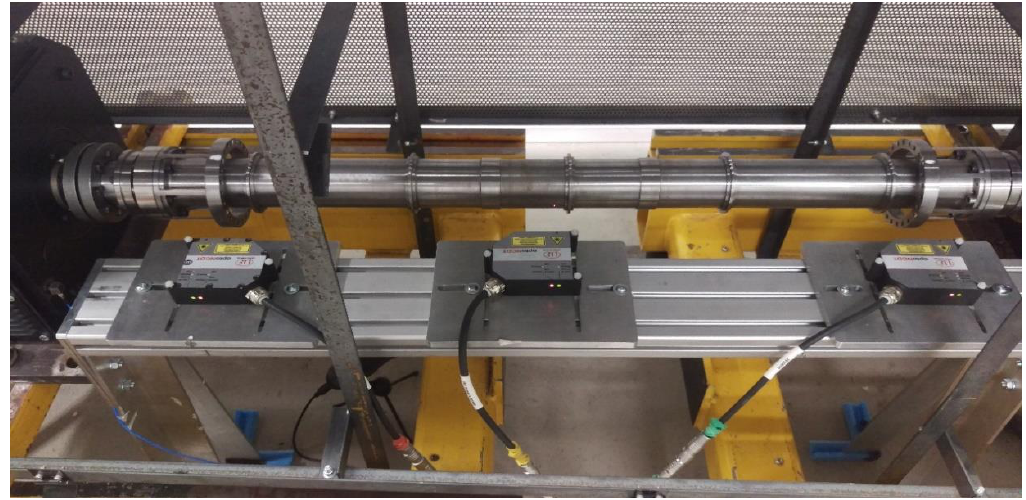
Figure 3. Laser displacement sensors measuring shaft.